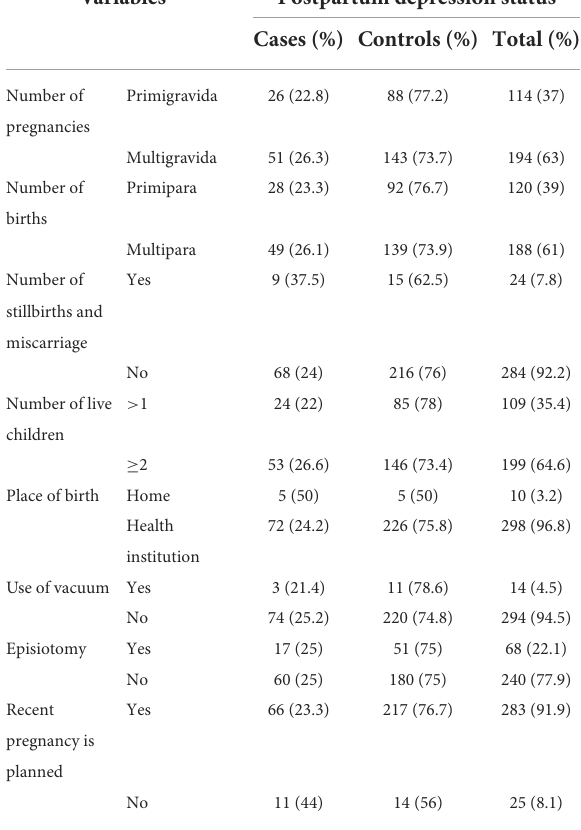
TABLE 1 Sociodemographic distribution of respondents by depression category in Debre Tabor Town.